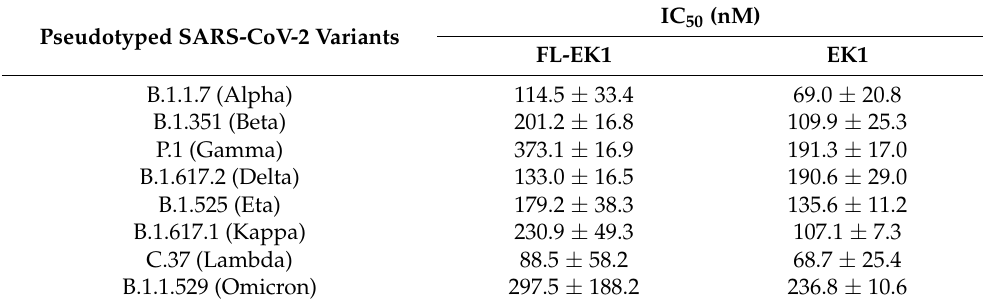
Table 1. Inhibitory activity of FL-EK1 and EK1 against pseudotyped SARS-CoV-2 variants. Pseudotyped SARS-CoV-2 Variants